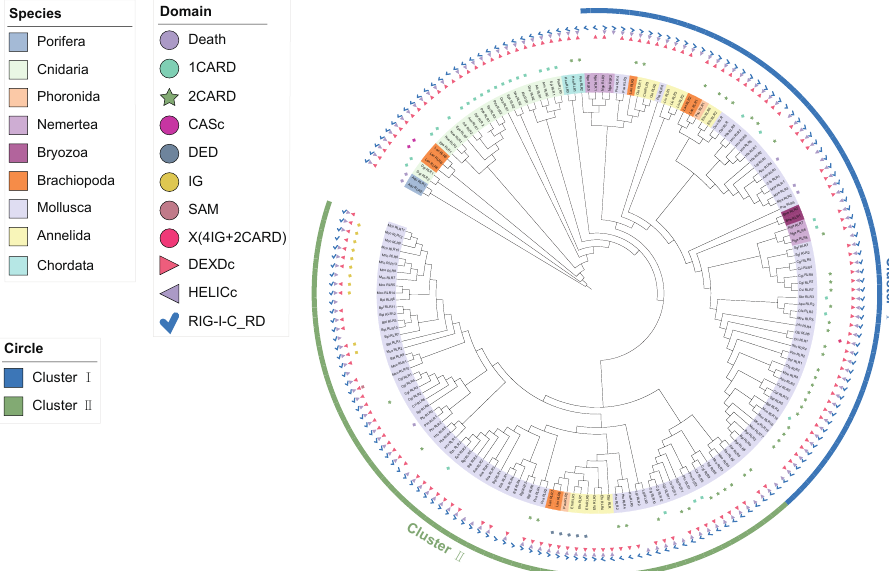
Figure 3. Phylogenetic analysis of RLRs based on C-terminal conserved domain RIG-I_C-RD. Maxi- mum likelihood trees were constructed using IQ-TREE. The species used for the tree generation were 30 lophotrochozoans (as shown in Figure 1), the poriferan A. queenslandica , cnidaria, and the chordate Homo sapiens . The lophotrochozoan RLRs can be majorly classified into two divergent classes, Cluster I and Cluster II. The background color on the gene name represents the phylum to which it belongs, as shown in the legend ‘Species’. The different colored shapes in the outer circles represent different types of domains, as shown in the legend